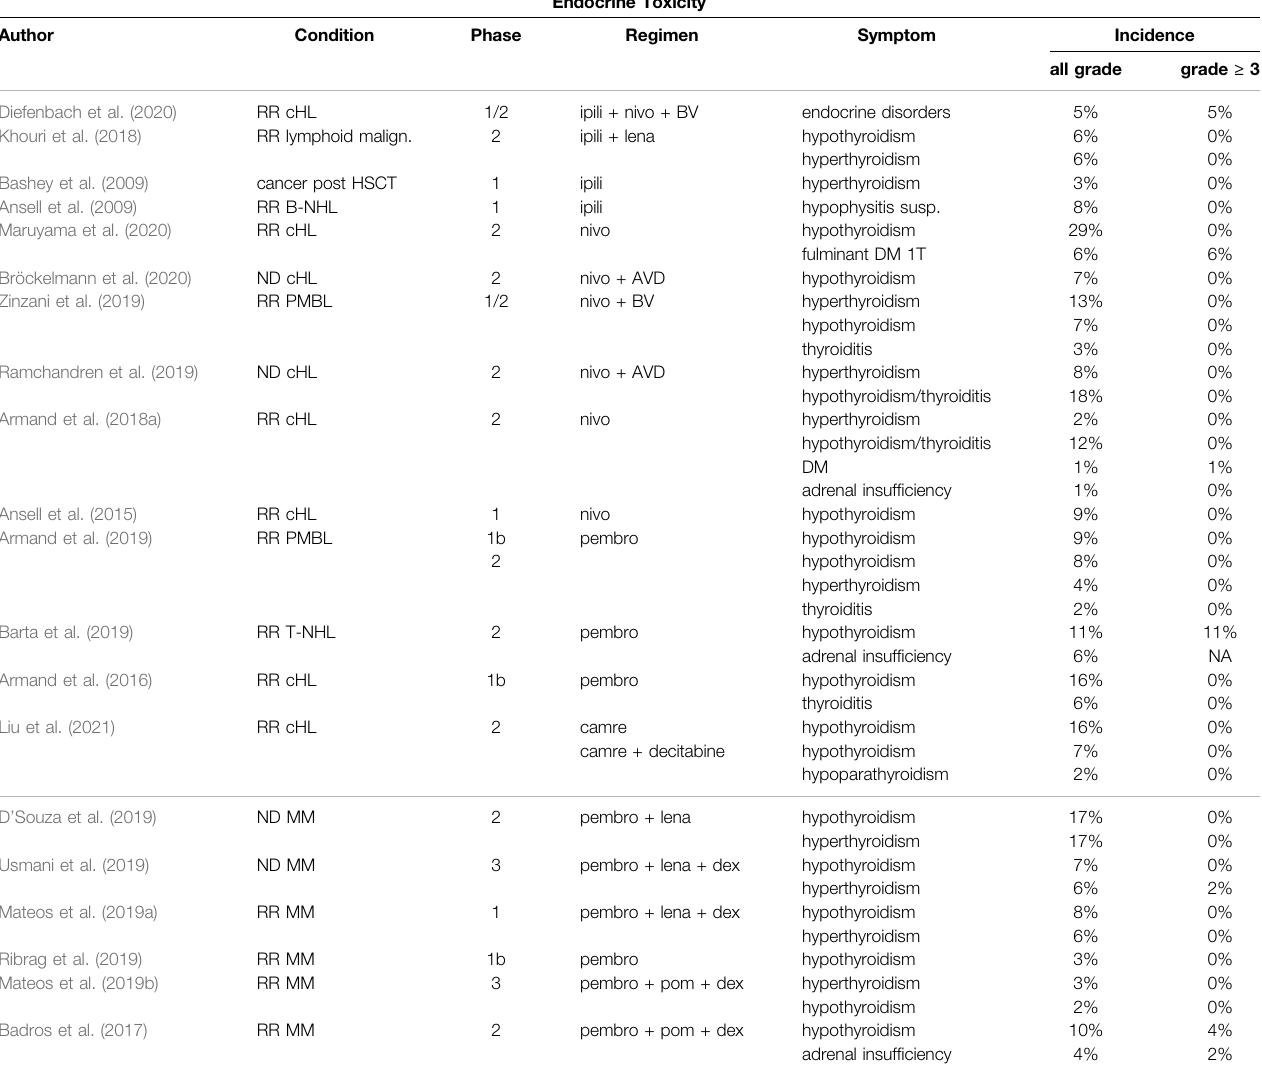
TABLE 2 | Incidence of endocrine irAEs in hematological